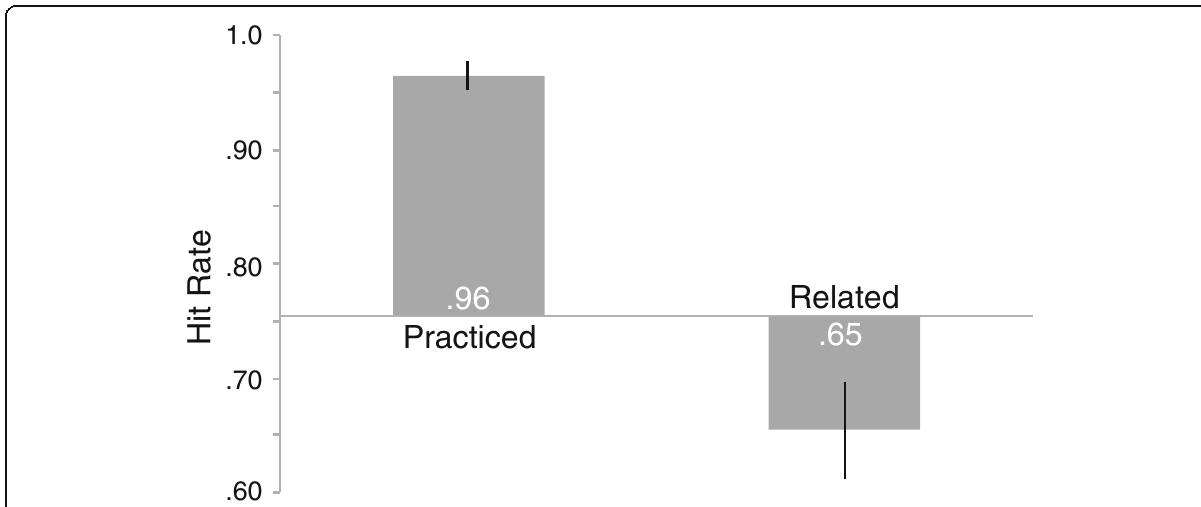
Fig. 3 Hit rate for old objects in the test phase by object type from Experiment 2. The x axis represents memory for baseline objects and error bars represent 95% confidence intervals as described by Cousineau (2005) with Morey ’ s correction applied (Morey,